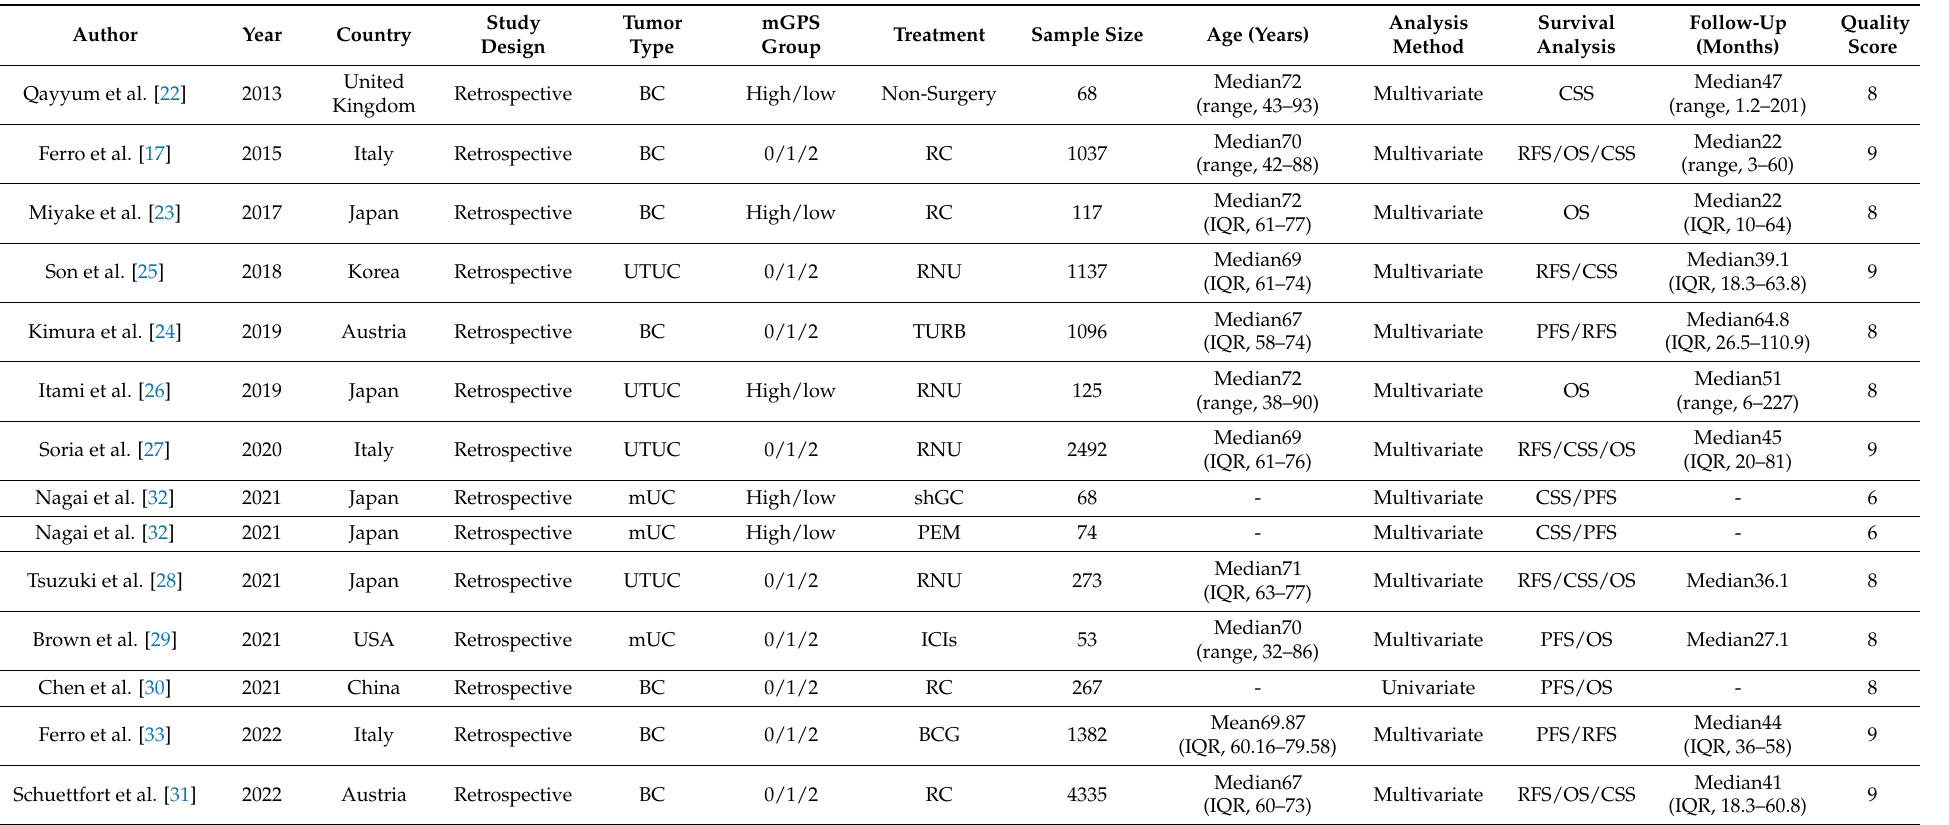
Table 2. Baseline characteristics of include studies and methodological